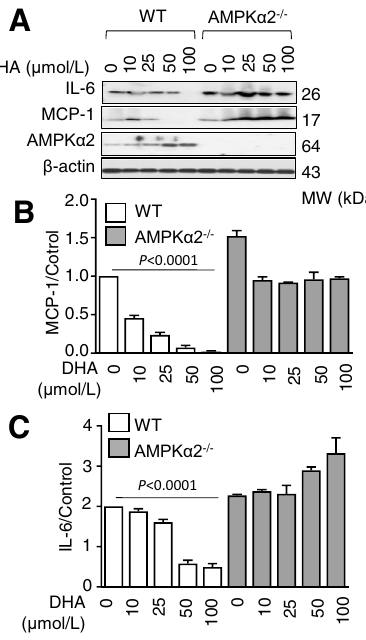
Fig. 3 | AMPK α 2 was required for the anti-in fl ammatory effects of DHA in cultured VSMCs. A Representative western blot ( A ) and quanti fi cation for the expression of MCP-1 ( B ) and IL-6 ( C ) in PA (300 μ M)-treated primary cultured WT andAMPK α 2 − / − VSMCswithDHA(0,10,25,50,100 μ M).Thedatashownrepresent one of at least two separate experiments ( n =2), distinctly from loading controls. ELISAs for MCP-1 ( D ) and IL-6 ( E ) in culture supernatants from WT or AMPK α 2